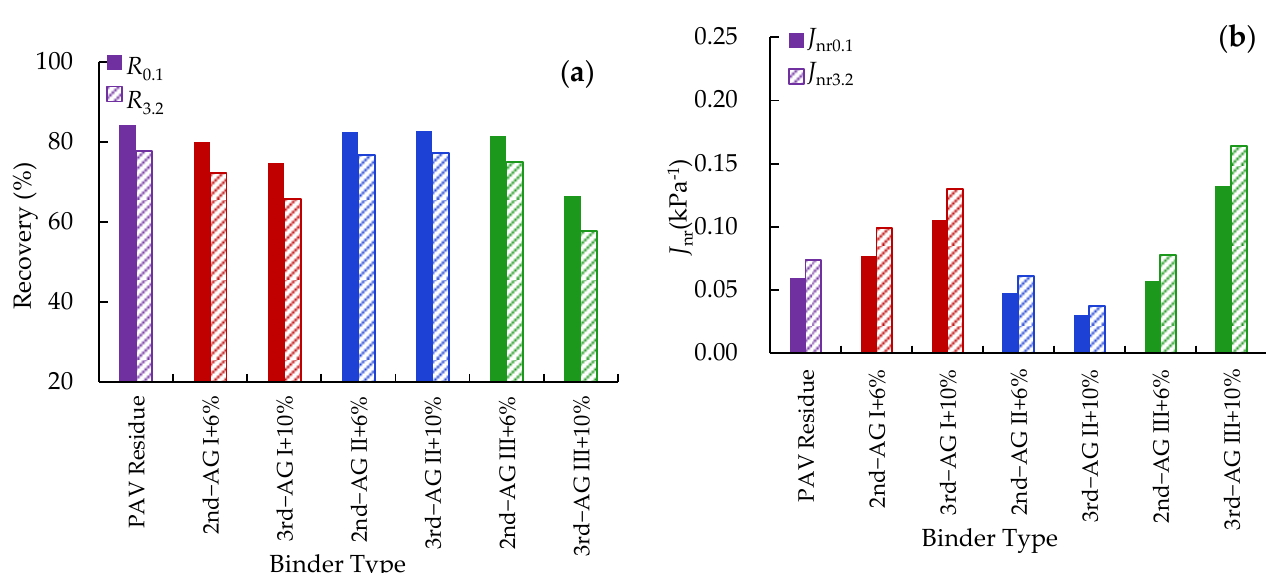
Figure 8. MSCR rutting evaluation of repetitively aged asphalt-binders: ( a ) recovery; ( b ) non-recoverable creep compliance ( J nr ) (Red bars: the asphalt-binders rejuvenated with Type I; blue bars: the asphalt-binders rejuvenated with Type II; green bars: the asphalt-binders rejuvenated with Type III).